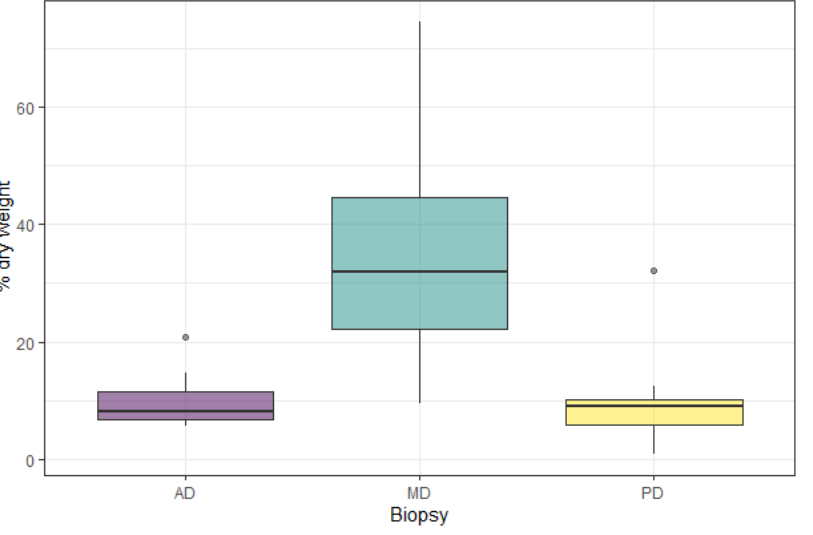
Figure 3. Total lipid (TL) content in anterodorsal (AD), mediodorsal (MD), posteriodorsal (PD) sites of muscle tissue in commercial beaked redfish Sebastes mentella . Figure 4 maps the profiles of individual lipid classes in the two redfish groups. The content of TAG, DAG, Chol, and NEFAs was significantly higher in the commercial product (9.3, 0.6, 1.2, and 2.4% dry weight, respectively) compared to wild specimens (1.4, 0.1, 0.9, and 0.3% dry weight, respectively) (Figure 4). Wild beaked redfish specimens demonstrated a significant prevalence of waxes (0.6 vs. 0.4% dry weight) and an insignificant prevalence of Chol esters (3.0 vs. 2.13% dry weight). The content of PLs and MAG was similar, no significant differences were found, in the two groups: in commercial samples—1.48% and 0.22% dry weight and in wild—1.23% and 0.19% dry weight.